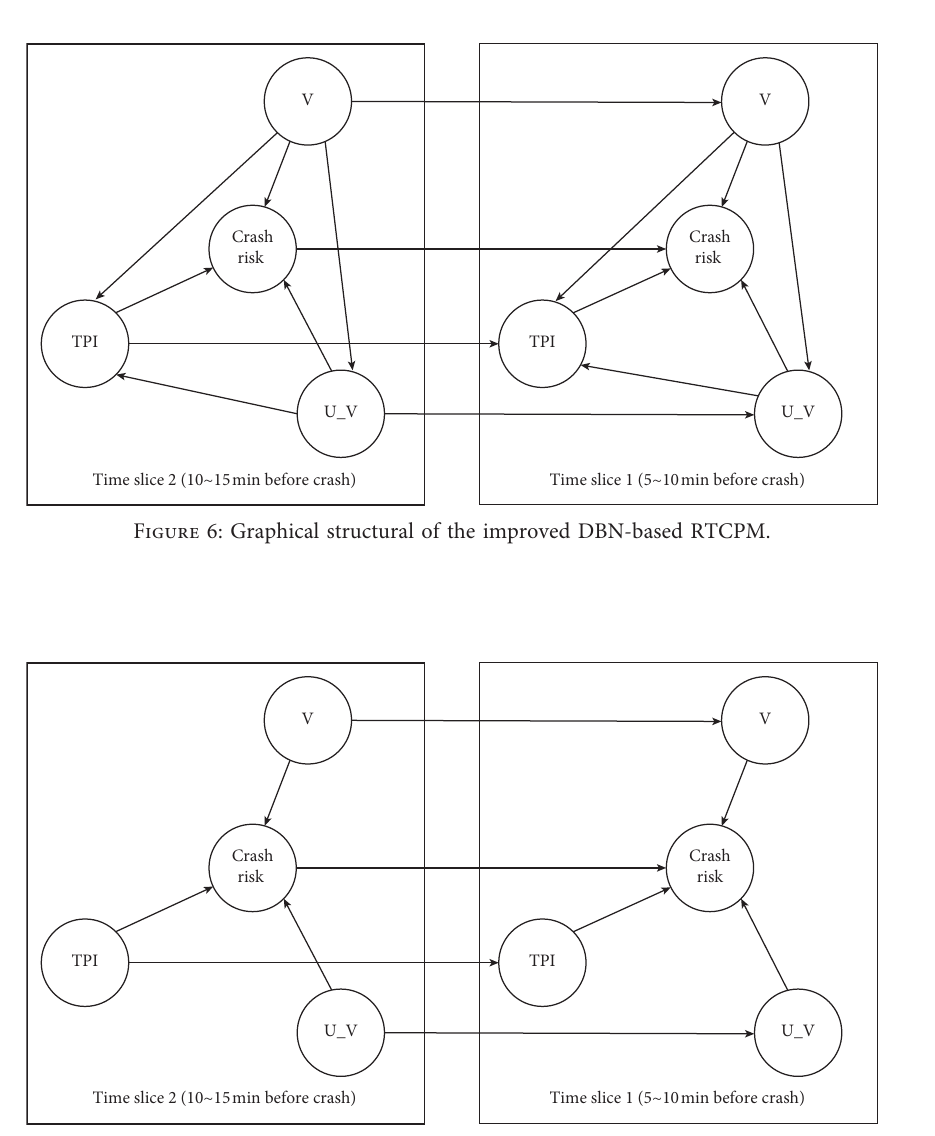
Figure 7: Graphical structural of the original DBN-based